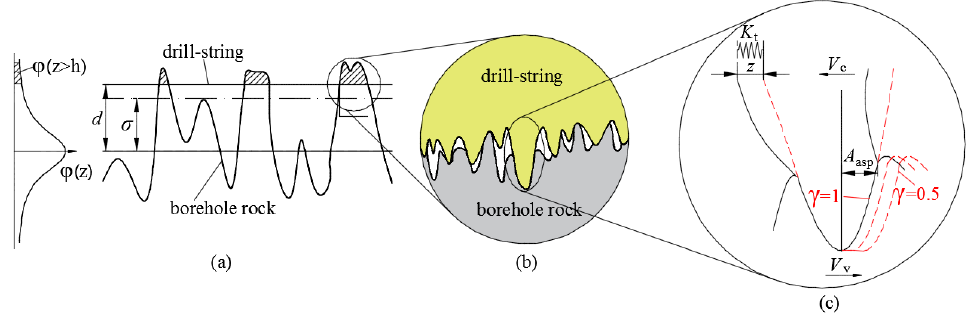
Figure 8. Real contact area on macroscopic scales. ( a ) Equivalent contact of drill-string and borehole wall; ( b ) asperities contact on micro-scale; ( c ) deformation of a single asperity.